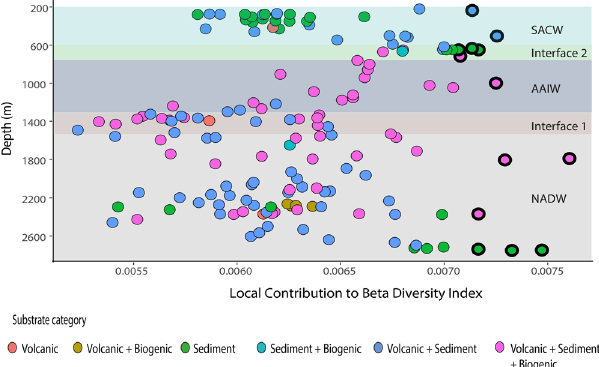
Figure 3. The Local Contribution to Beta Diversity Index of the 100 m length samples per substrate and water mass type. The black circles illustrate the significant samples at p < 0.05, n =